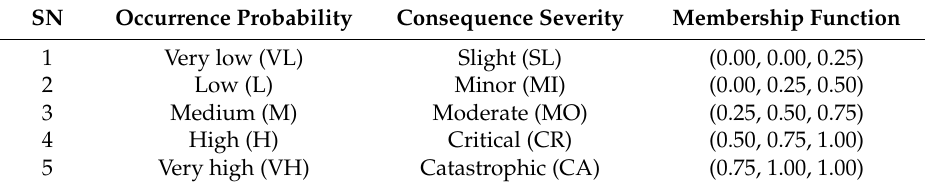
Table 1. Fuzzification transformation results with the triangular fuzzy number